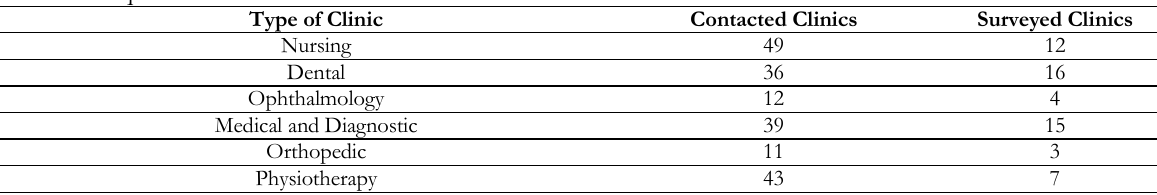
Table 2. Inquired